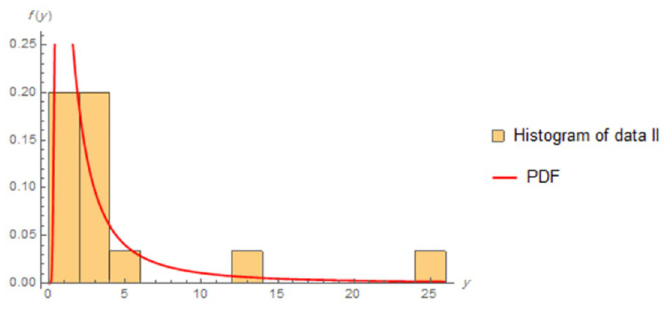
Fig 7. Estimated PDF of data